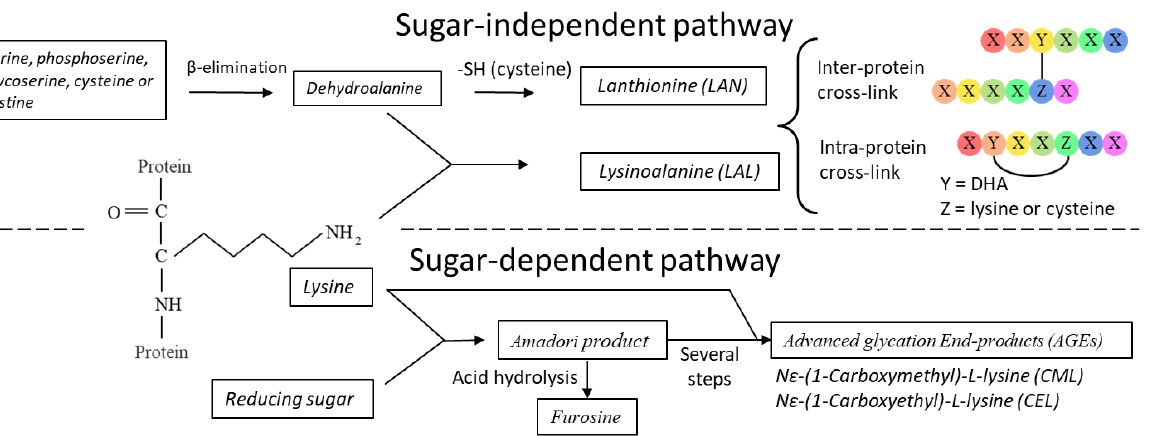
Figure 1. Formation of processing-induced protein modifications from the sugar-independent DHA or sugar-dependent Maillard reaction pathways.